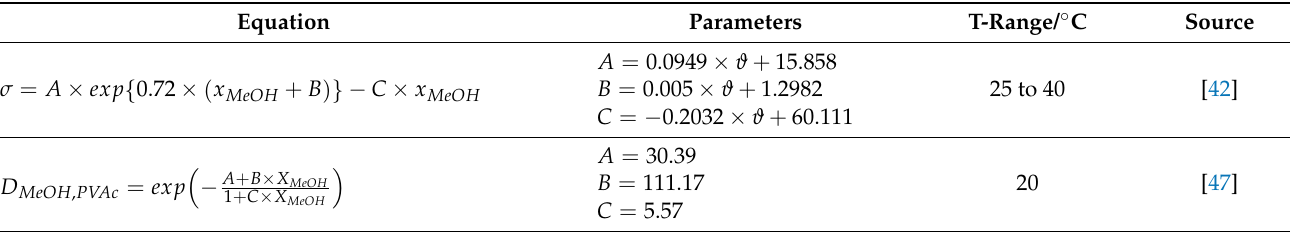
Table A4. Concentration-dependent surface tension σ and mutual mass diffusion coefficient D from pol(vinyl acetate)- methanol solutions with ϑ being the temperature in ◦ C, as well as x MeOH and X MeOH being the methanol mass fraction and methanol solvent load,